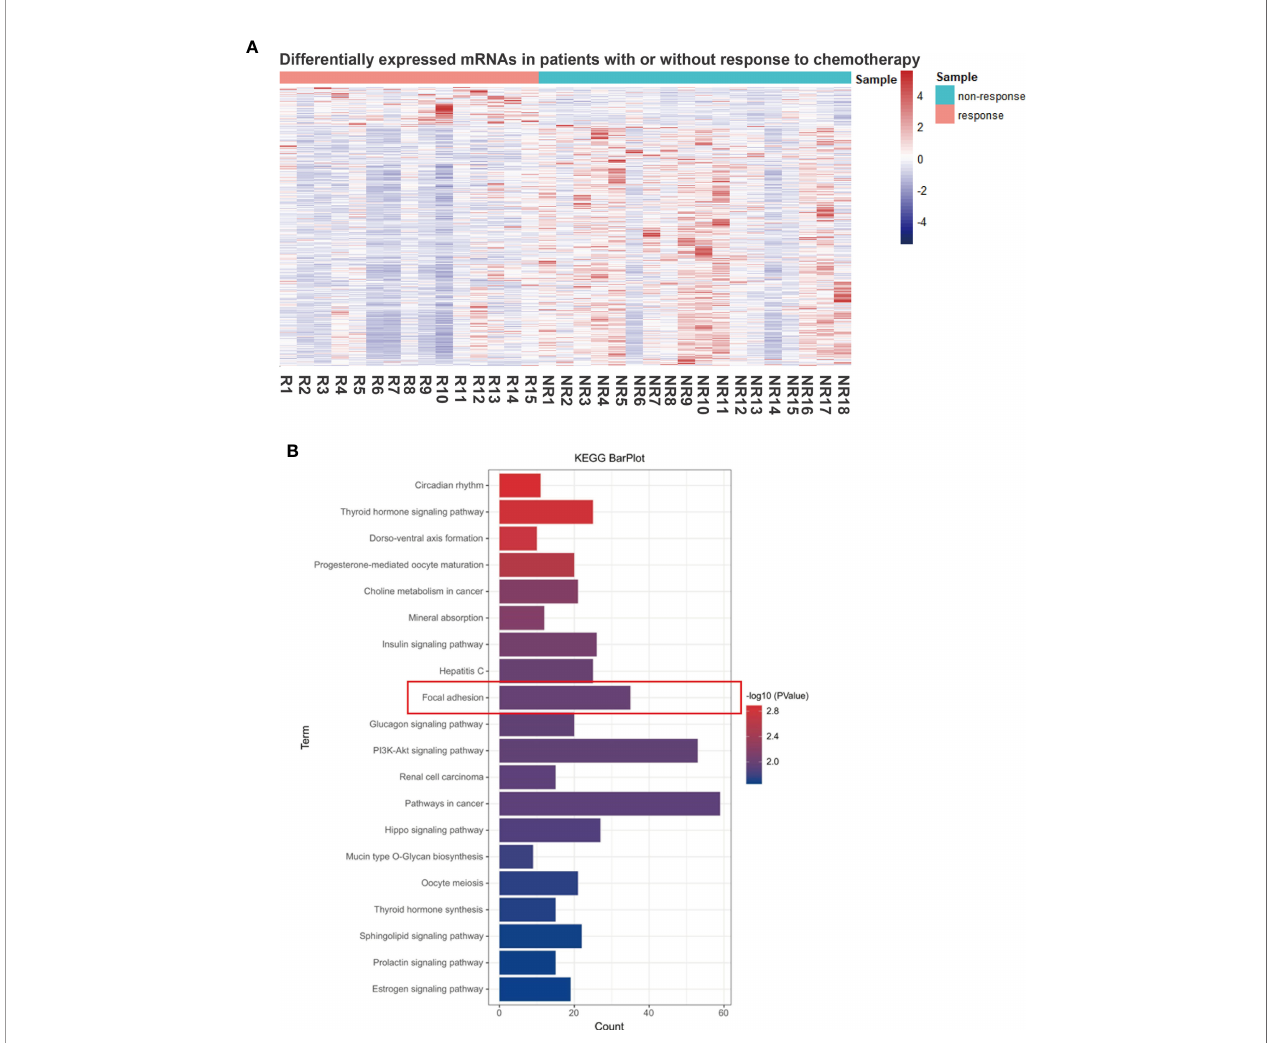
FIGURE 1 | Focal adhesion is a signi fi cantly relevant pathway for the treatment ef fi cacy of neoadjuvant chemotherapy in GC. (A) Differentially expressed genes (DEGs) between the responders (tumor regression grading 1, TRG 1) and non-responders (TRG 3). (B) The functional enrichment of DEGs was assessed based on Kyoto Encyclopedia of Genes and Genomes (KEGG) pathways and focal adhesion was identi fi